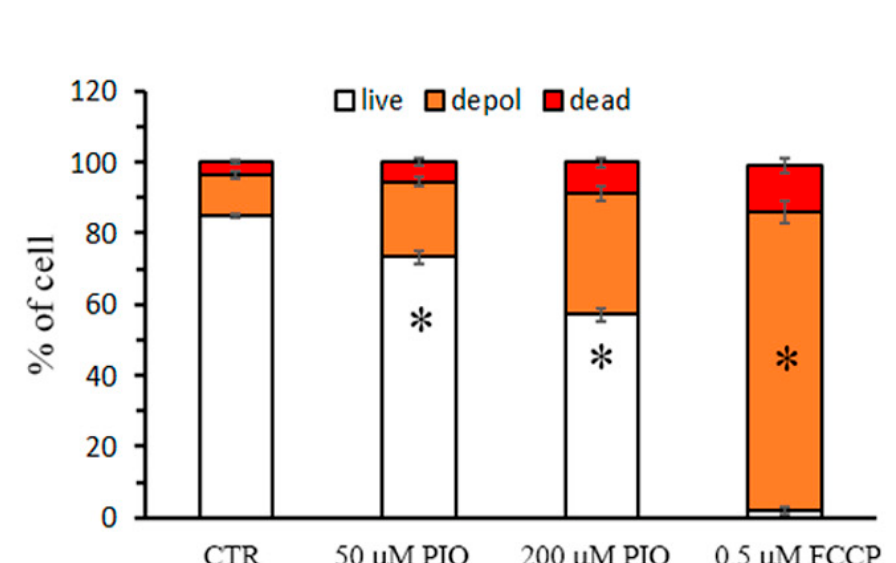
Figure 6. PIO decreases ∆Ψ m in isolated intact thymocytes. ( A – D ) Typical plots obtained in the absence of additions ( A , Control), in the presence of 50 ( B ) and 200 µ M PIO ( C ), and 500 nM FCCP ( D ). ( E ) The portion of depolarized cells in different experimental groups (means ± SEM, n = 3). * Statistically significant ( p < 0.05) differences from control (without